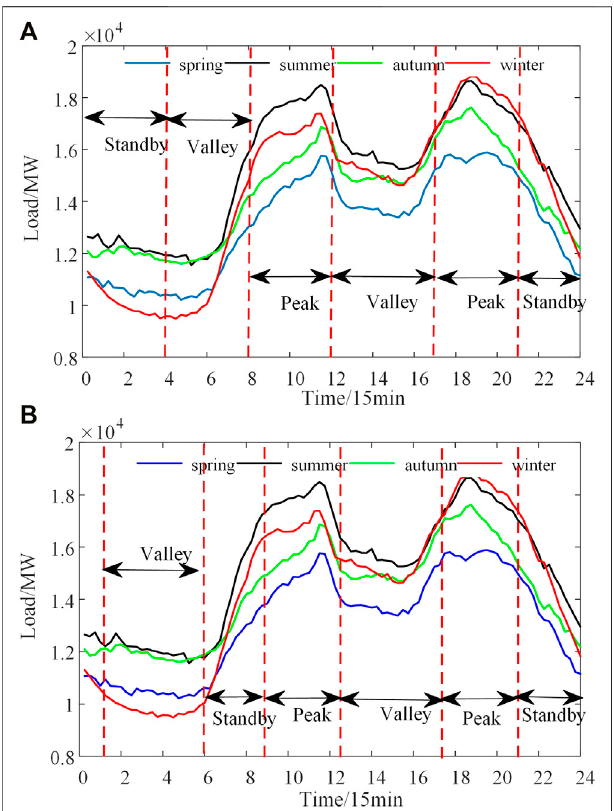
FIGURE 9 | Division curves of peak and valley periods of different seasonal loads. (A) Fixed peak-valley period. (B) The improved method divides peak and valley periods.